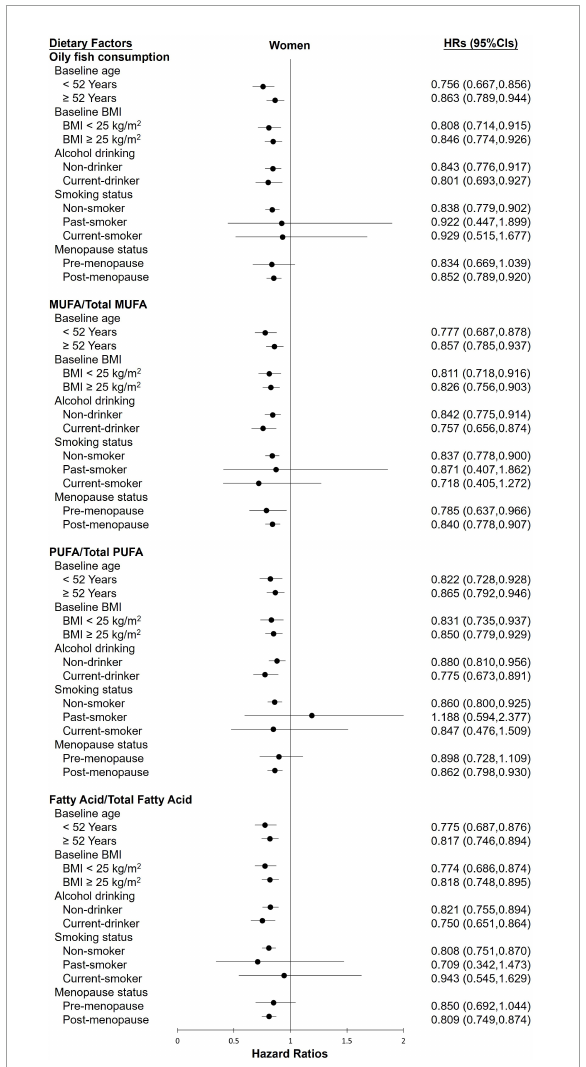
FIGURE2 The HRs of FLI-non-alcoholic fatty liver disease for the highest categories compared with the lowest categories of oily fish and its fatty acid intake among female participants in the current cohort study. Analyses were stratified by body mass index (BMI), age, smoking status, drinking status, and menopause status. HRs, hazard ratios; MUFAs, monounsaturated fatty acids; PUFAs, polyunsaturated fatty